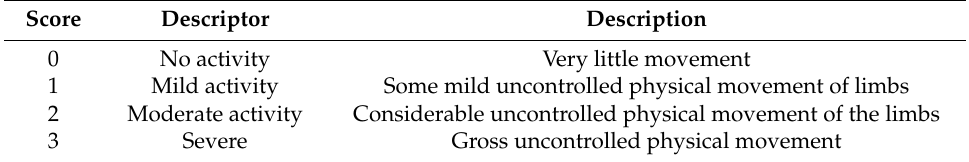
Table 1. Subjective scoring system used to assess post-stun/kill movement based on level of